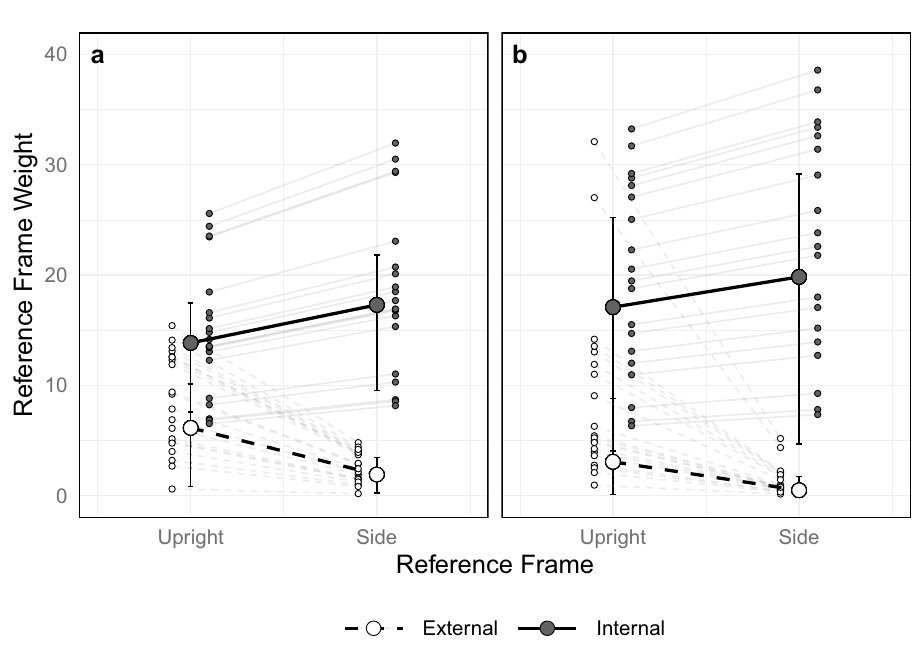
Figure 2. Overall proportion of right-first responses while wearing ( a ) no blindfold and ( b ) a blindfold. Participants indicated which hand was vibrated first, and the average proportion of ‘right-first’ responses was calculated at each SOA. Negative SOAs indicate the left hand received the vibration first. The average PCD score for each condition is represented in the bar graphs. Error bars represent standard error of the mean corrected for a within-subject design 15,16 .